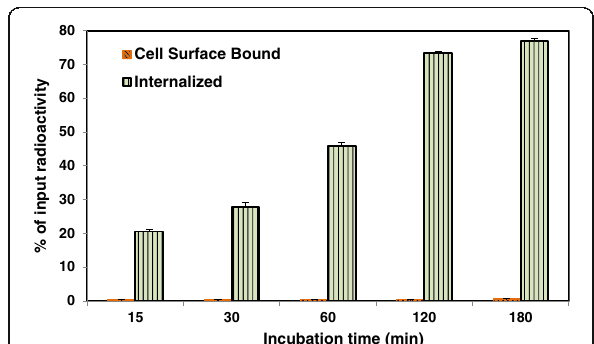
Fig. 5 Internalization of 4-[ 18 F]FEBZA into B16F1 cells (~5 × 10 5 cells/ well) at 37 °C. The data represents the percent of total cell-associated radioactivity and is the mean ± SD ( n = 4). Majority of the cell- associated radioactivity is internalized and the cell surface bound fraction amount is negligible (<1%) at all time points and the remainder of the radioactivity was present in the media. The internalized fraction increased with time and reached plateau by about 120